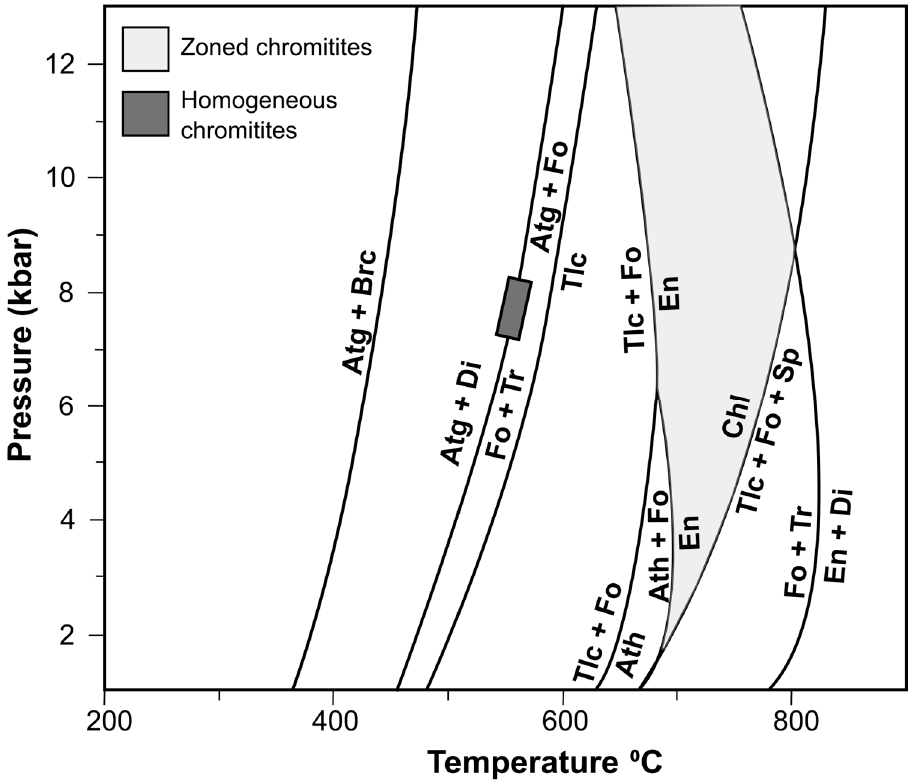
Figure 11. CaO-MgO-SiO 2 -H 2 O phase equilibria of ultramafic rocks [66,67]. Abbreviations: Atg = antigorite, Brc = brucite, Di = diopside, Fo = Forsterite, Tr = tremolite, Tlc = talc, Ath = anthophyllite, Chl = chlorite, Sp = spinel, En =